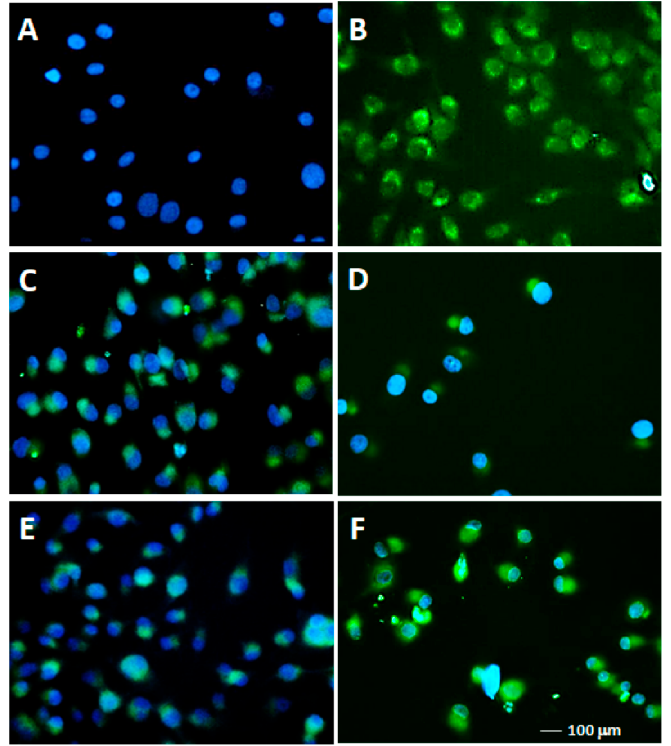
Figure 7. TUNEL assays. To highlight the DNA fragmentation of apoptosis, TUNEL assays were performed on the SK cells, as described in the Materials and Methods. Cells were seeded on chamber slides and then untreated ( A ) or treated with 5–10 µ M of either 11 ( C , D ) or 12 ( E , F ) for 24 h. Samples ( B ) were SK cells treated with TACS nuclease. The slides were observed with the Olympus BX61 fluorescence microscope with a FITC filter, 20 × magnification. DAPI (blue fluorescence) was used as the contrast dye to highlight the nuclei.